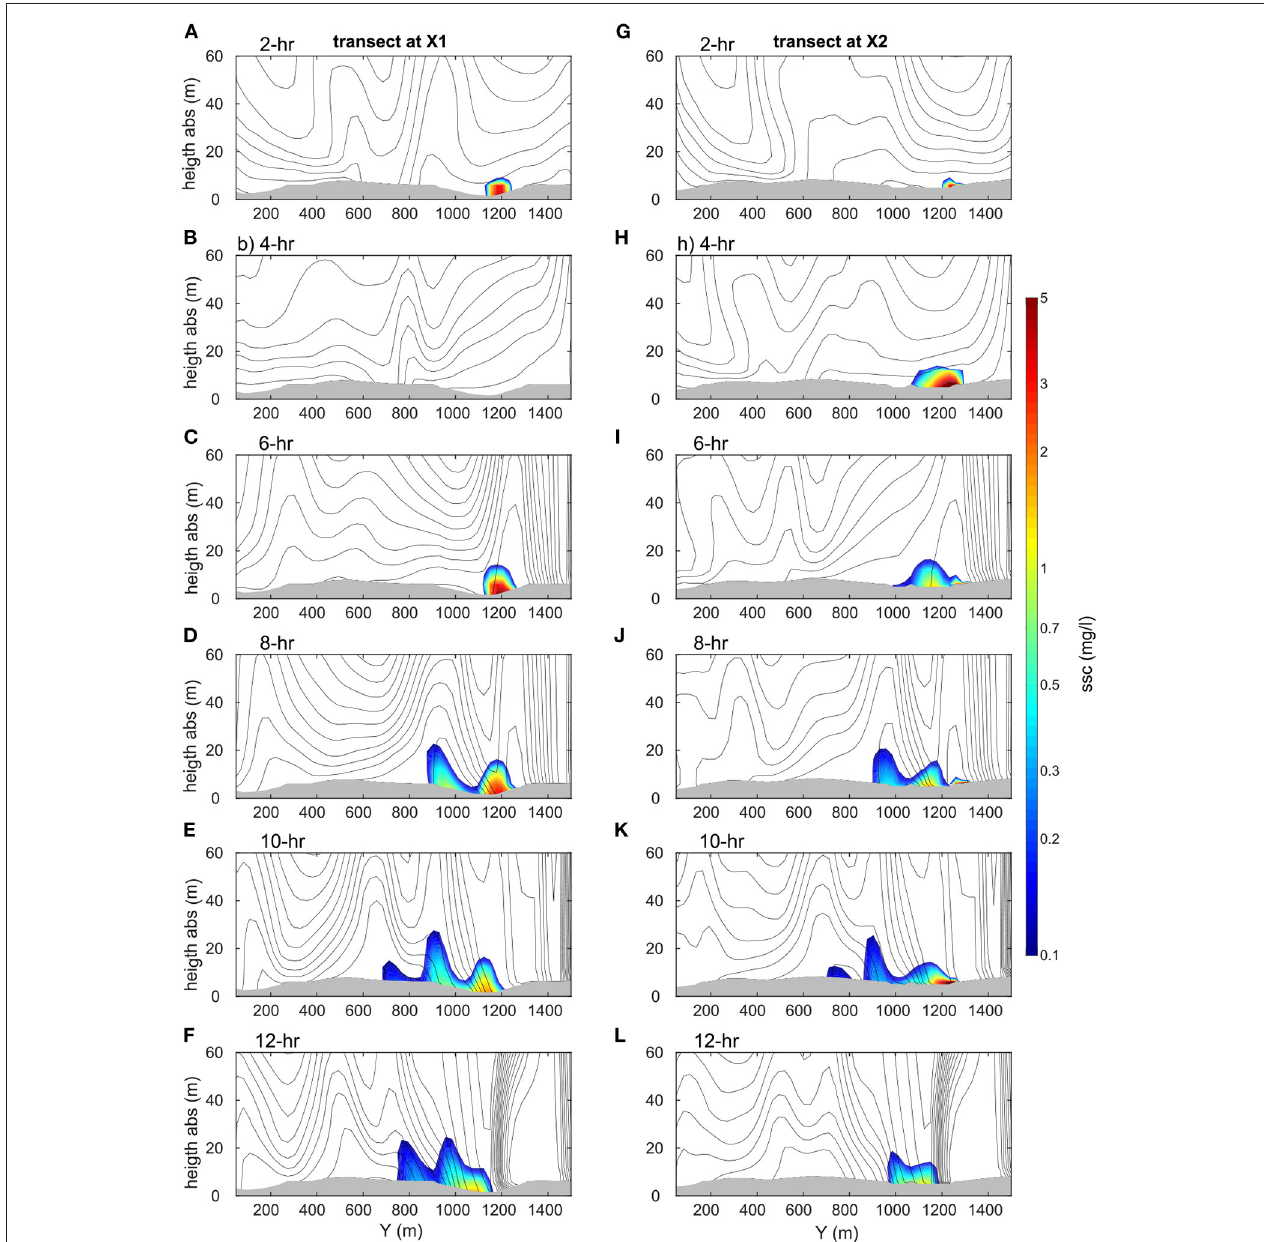
FIGURE 11 | Lateral transect of sediment plume distribution at transect X1 at (A) 2 h, (B) 4 h, (C) 6 h, (D) 8 h, (E) 10 h, and (F) 12 h after dredging. Overlying contours show isolines of potential temperature. Temperature contour interval is 0.002 ◦ C with lowest temperature depicted as 1.2 ◦ C. (G–L) shows lateral transect of plume distribution similar to above but at transect X2. X1 and X2 are the lateral transects at the locations of stations PFM06 and PFM02 (see Figure 1c